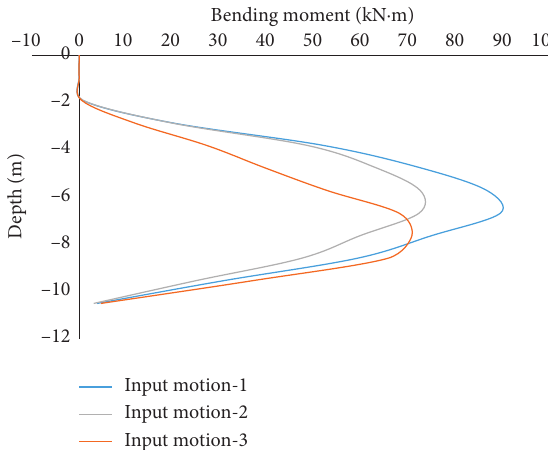
Figure 13: Bending moment variations along the single